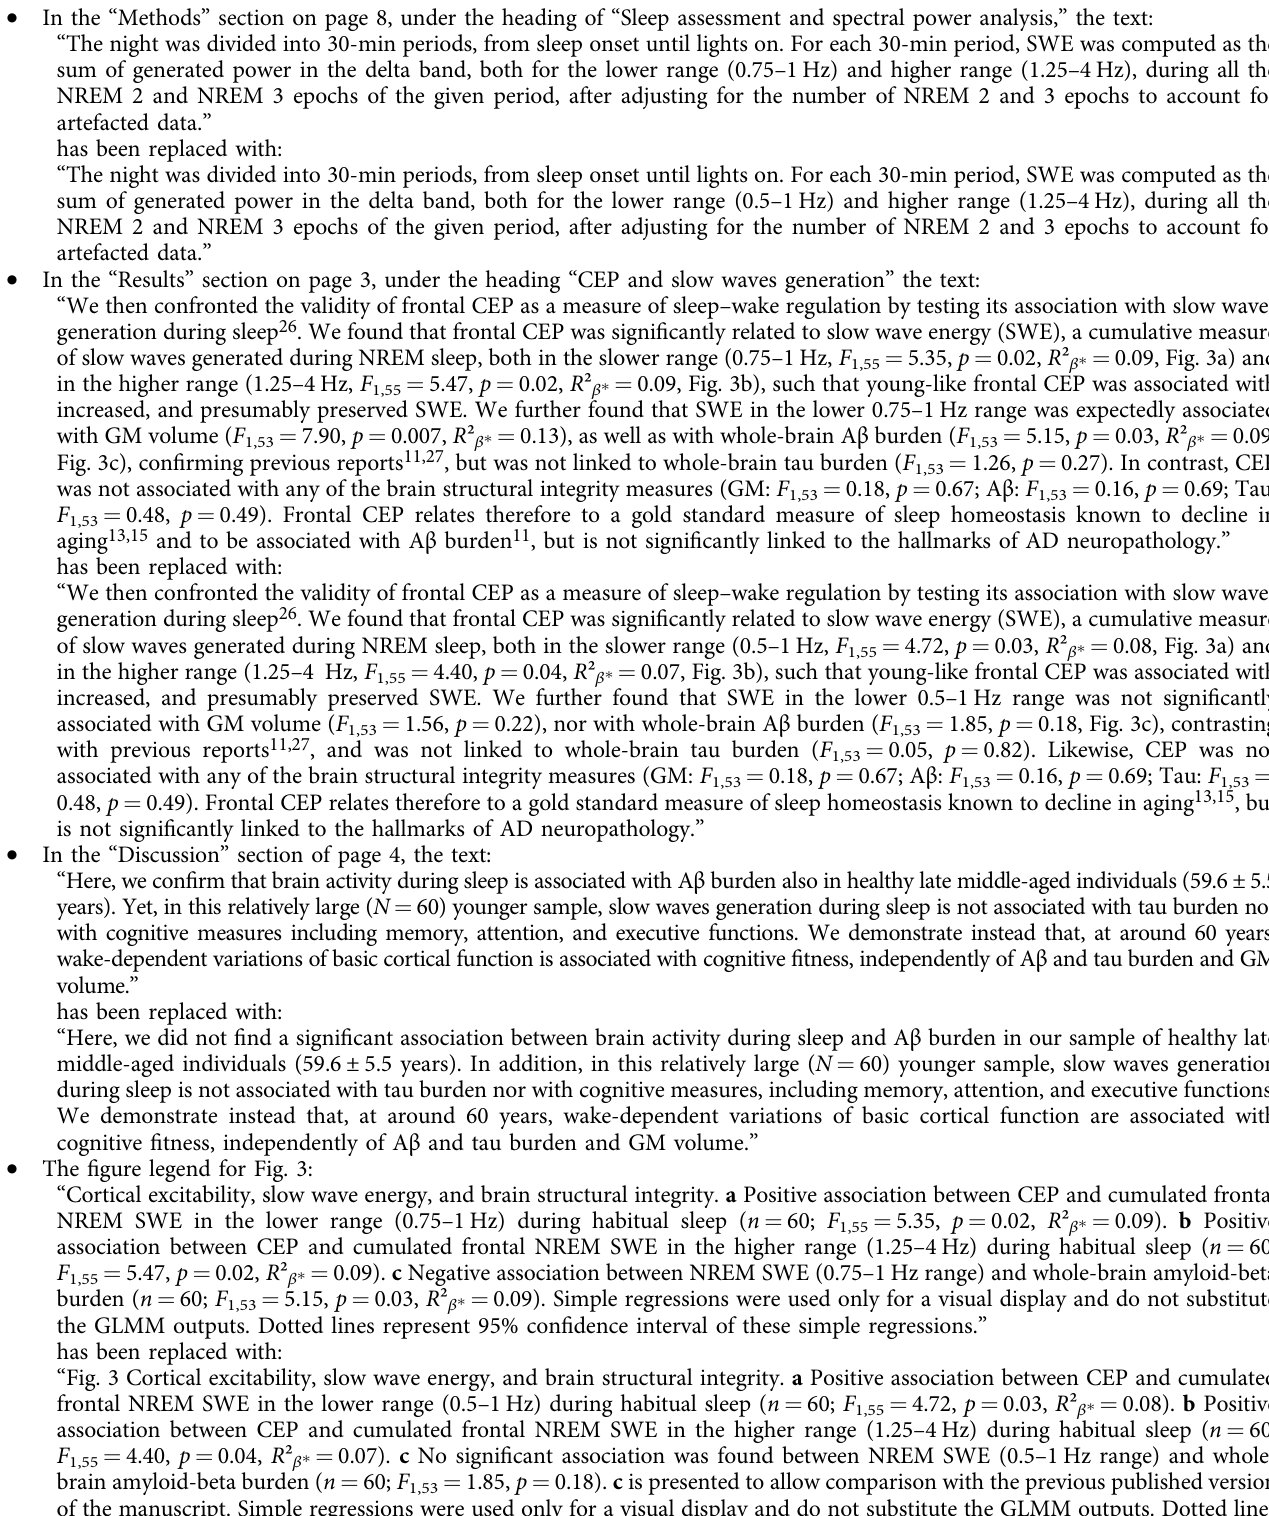
The fi gure legend for Fig. 3: “ Cortical excitability, slow wave energy, and brain structural integrity. a Positive association between CEP and cumulated frontal NREM SWE in the lower range (0.75 – 1 Hz) during habitual sleep ( n = 60; F 1,55 = 5.35, p = 0.02, R ² β * = 0.09). b Positive association between CEP and cumulated frontal NREM SWE in the higher range (1.25 – 4 Hz) during habitual sleep ( n = 60; F 1,55 = 5.47, p = 0.02, R ² β * = 0.09). c Negative association between NREM SWE (0.75 – 1 Hz range) and whole-brain